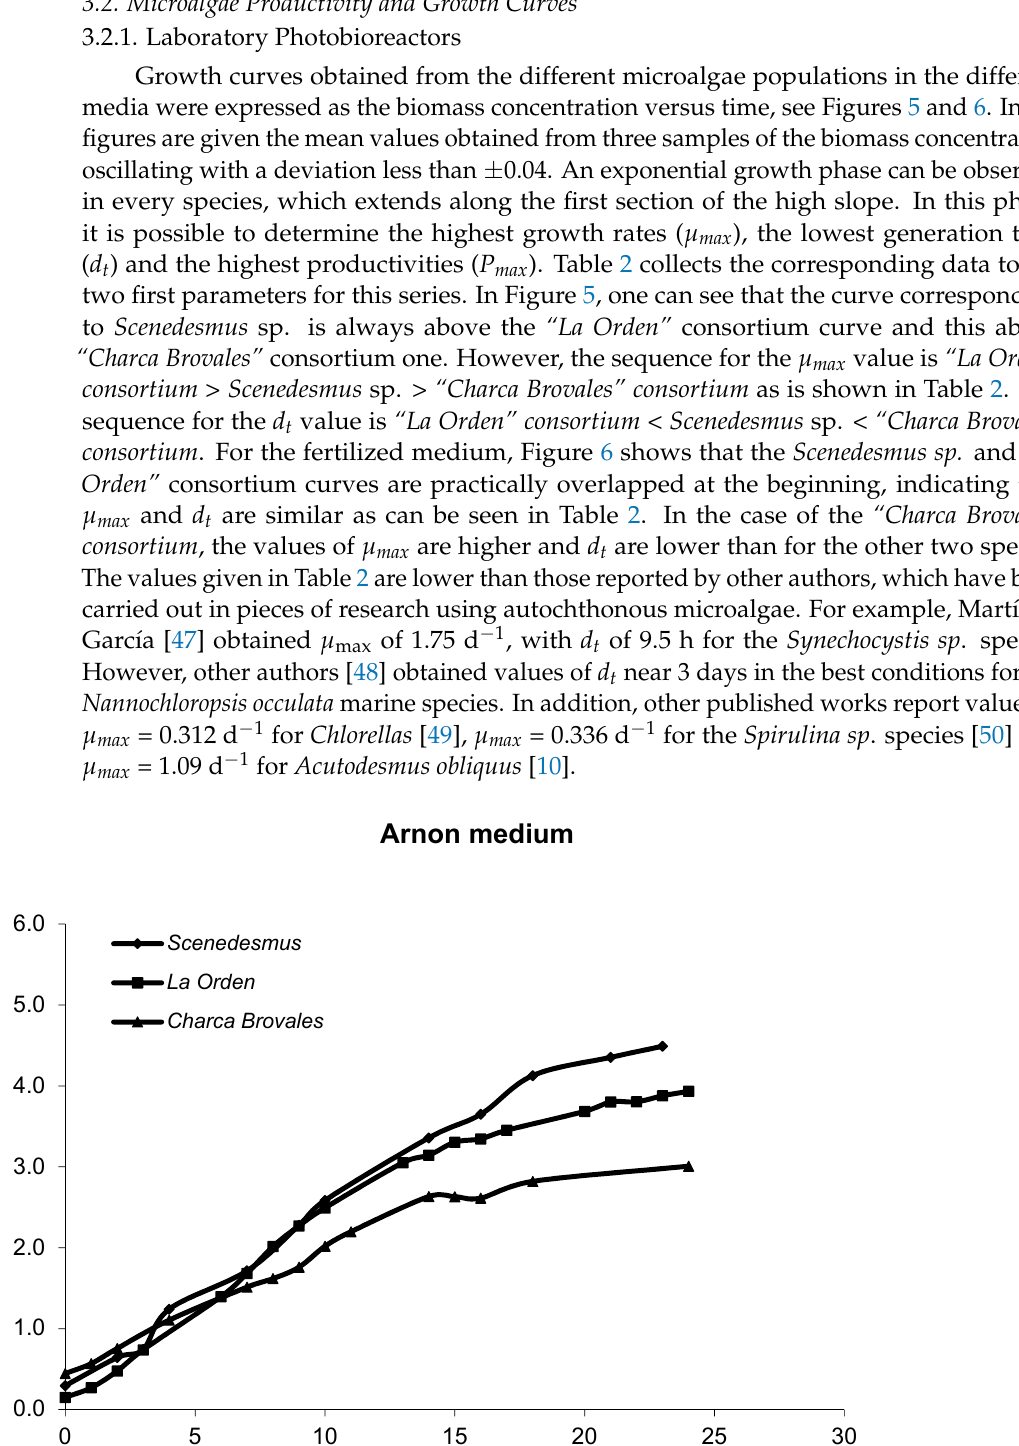
0.01.02.0 Figure 5. Growth curves of the different microalgae populations cultured in Arnon medium. Figure 6. Growth curves of the different microalgae populations cultured in fertilizer medium. In this work, values of μ máx and d t of 0.504 d − 1 and 1.35 days and 0.408 d − 1 and 1.71 days were obtained for the Scenedesmus sp. species in AM and FM cultures, respectively. For this reference species, higher growth rates could be expected, since the bibliography report studies that, in similar conditions to the ones used in this work, have been obtained